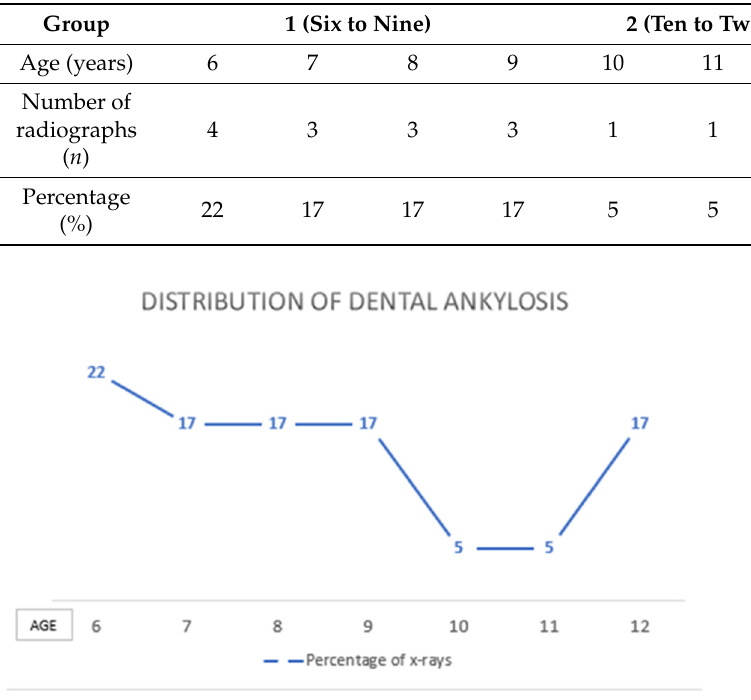
Figure 1. Distribution of dental ankylosis according to the age of the subjects.